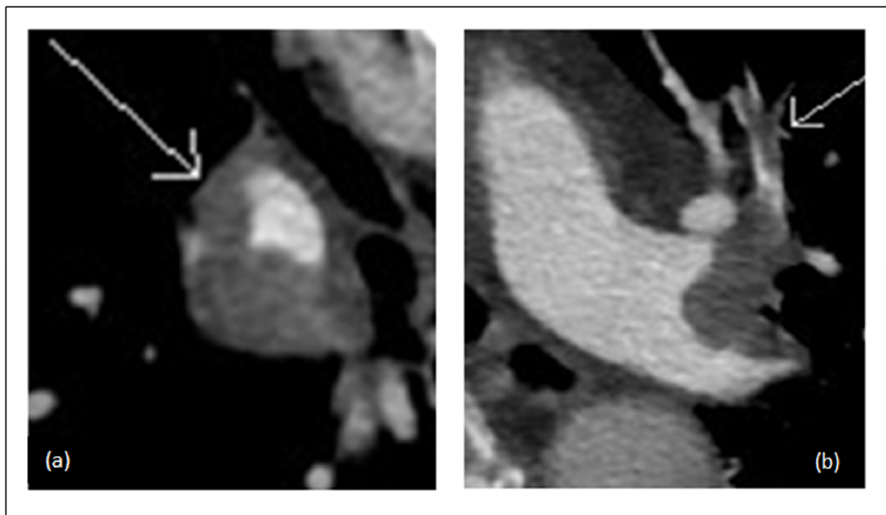
Figure 2. CT angiography in a patient with acute pulmonary embolism. ( a ) Partial occluding thrombus in right basal trunk (Modified Miller score = 4); ( b ) Partial occluding thrombus in the left apical anterior segmental artery (Modified Miller score = 1).